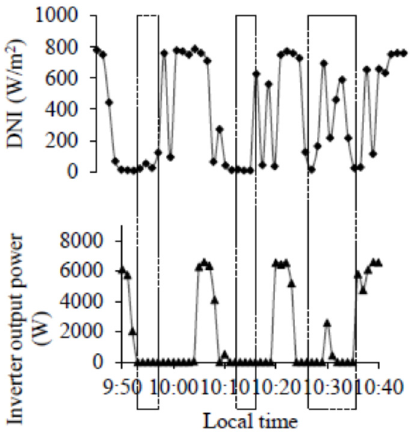
Figure A2. Comparison of the DNI and output power of the HCPV system measured at a typical period of time in wet season (11 September 2014).